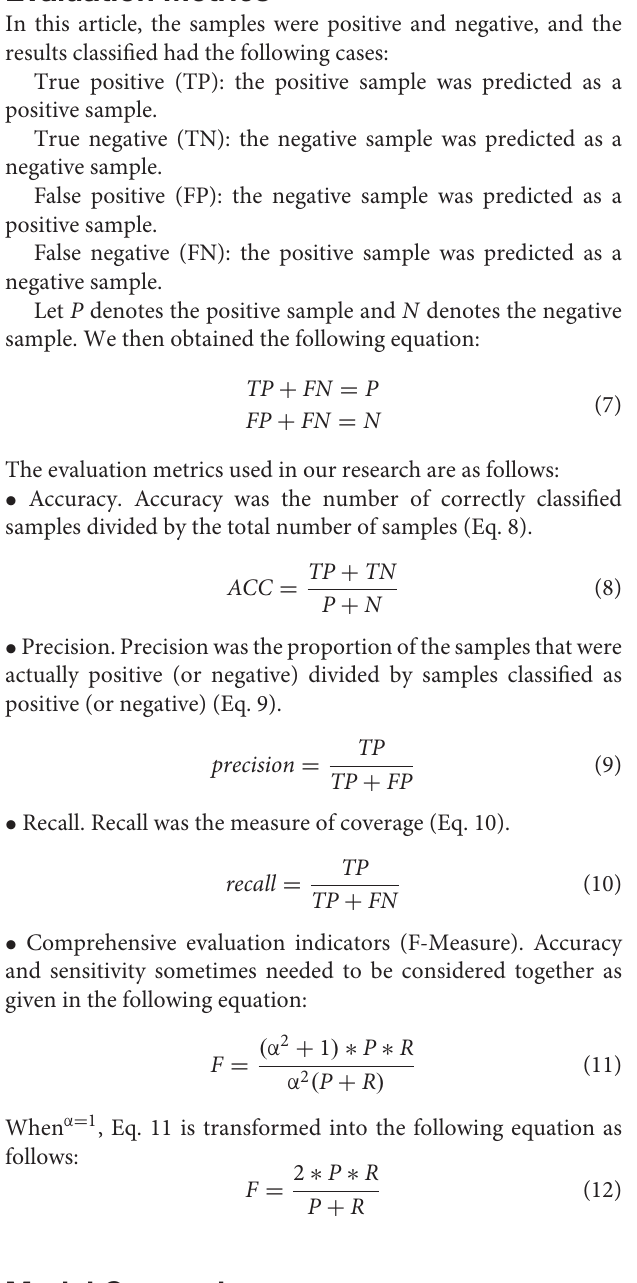
TABLE 1 | Participant